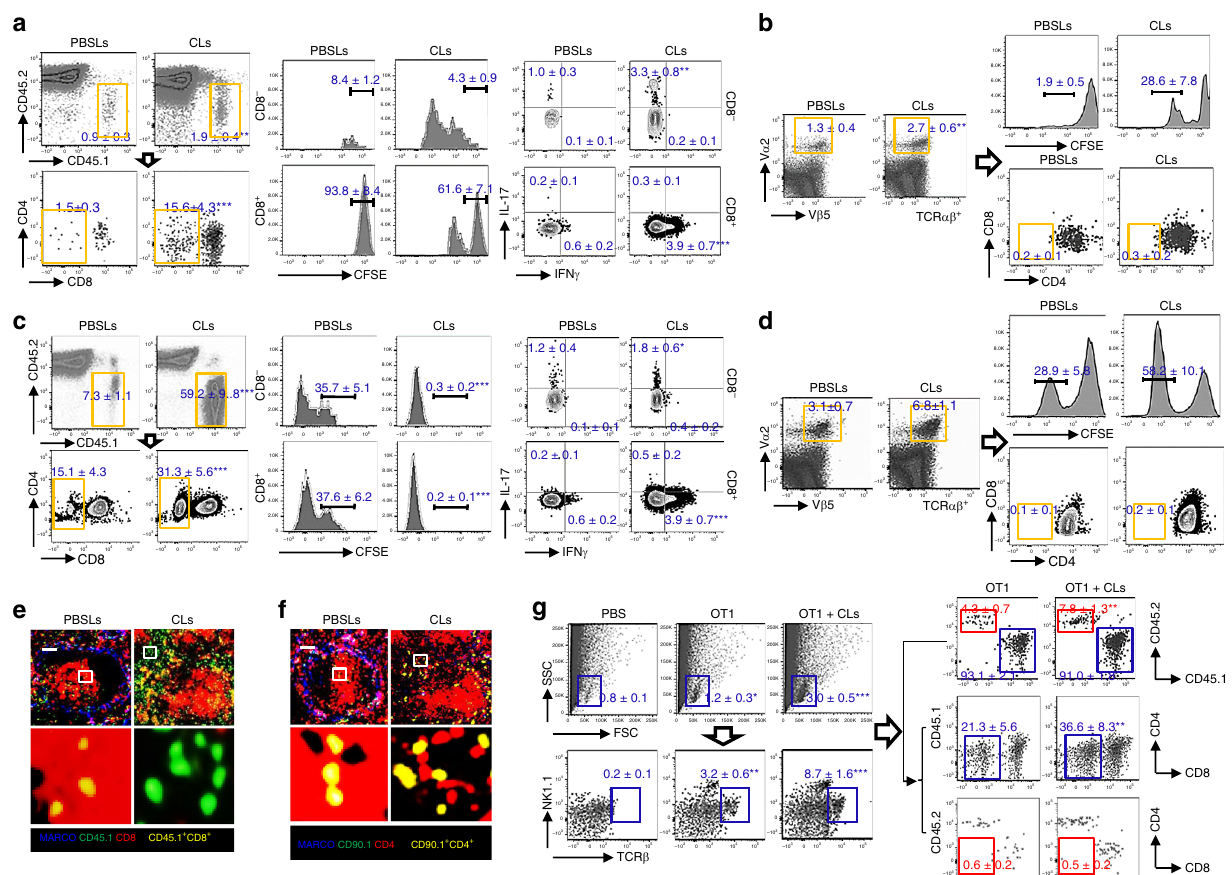
Fig. 2 Exposure to apoptotic cell debris induces loss of CD8, but not CD4 expression. CD8 T cells from Cd45.1 OT-I TCR Tg Rag1 − / − B6 mice ( a ) or CD4 T cells from Cd90.1 OT-I TCR Tg Rag1 − / − B6 mice ( b ) were labeled with CFSE and i.v. transferred. Recipients were administered with CLs or control liposomes, apoptotic m-OVA Tg thymocytes, 12 h and 16 h later sequentially. Mice were sacri fi ced after an additional 72 h. a Left: fl ow cytometry analysis of cell surface CD8 expression on transferred OT-I CD8 T cells; middle: fl ow cytometry analysis of in vivo OVA-antigen-speci fi c responses indicated by attenuation of CFSE intensity. Right: fl ow cytometry quantitation of the percentage of IL-17 + and IFN- γ + cells in CD8 − and CD8 + populations. b Flow cytometry analysis of cell surface CD4 expression on transferred OT-II V α 2 + V β 5 + CD4 T cells. In vivo OVA responses were indicated by attenuation of CFSE intensity. CD8 from Cd45.1 OT-I Rag1 − / − B6 mice ( c , e , g ) or CD4 T cells from Cd90.1 OT-II Rag1 − / − B6 mice ( d , f ) were labeled with CFSE and i.v. transferred into m-OVA Tg B6 mice administered with CLs or control liposome 4 h before and sacri fi ced after an additional 72 h. c Left: Flow cytometry analysis of cell surface CD8 expression on transferred OT-I T cells. Middle: fl ow cytometry analysis of in vivo OVA responses indicated by attenuation of CFSE intensity. Right: fl ow cytometry quantitation of the percentage of IL-17 + and IFN- γ + cells in CD8 − and CD8 + populations. d Flow cytometry analysis of cell surface CD4 expression on transferred OT-II T cells. In vivo OVA responses were indicated by attenuation of CFSE intensity. e , f Immuno fl uorescent staining of transferred OT-II ( e ) or OT-I T cells ( f ). Upper: magni fi cation, ×20. Scale bar: 50 µ m; Lower: digitally magni fi ed views of the boxed areas in the upper panels. g Flow cytometry analysis of in fi ltrating T cells from both donors and recipients in the kidneys from indicated mice. Data represent the mean ± SEM, * P < 0.05, ** P < 0.01, *** P < 0.005 vs. indicated control, two-tailed Student ’ s t test. n = 4 – 5 mice per group for two independent